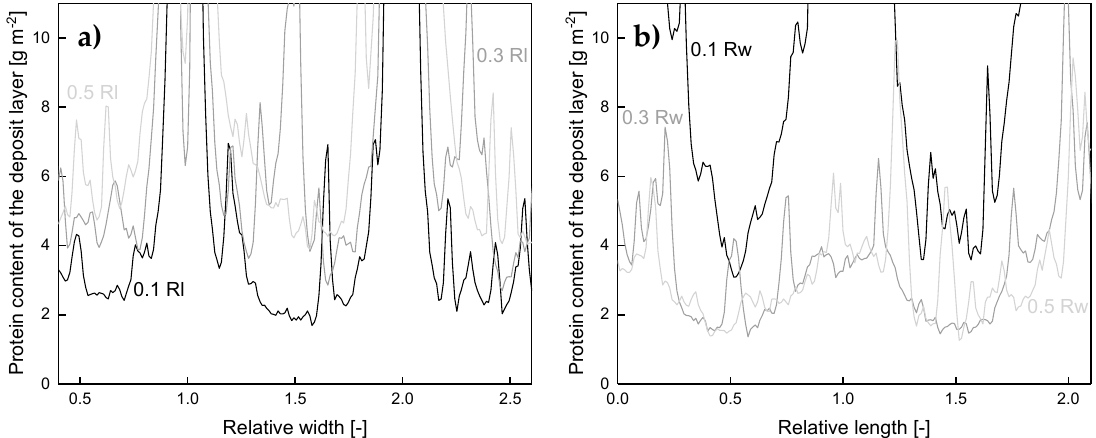
Figure 8. Deposited protein on the membrane surface after filtration of concentrated skim milk (CF 3) as a function of the axial position on lines parallel to the spacer strands without ( a ) and with ( b ) membrane contact in varying distance. One Rl / Rw refers to the distance between the centers of two adjoining spacer strands and corresponds to 3.5 mm. The Rl and Rw of 0, 1, and 2 are at the middle of the spacer strand. Graphs show data obtained from a single experiment. Values above 10 g m − 2 could only be determined qualitatively and are therefore not shown.